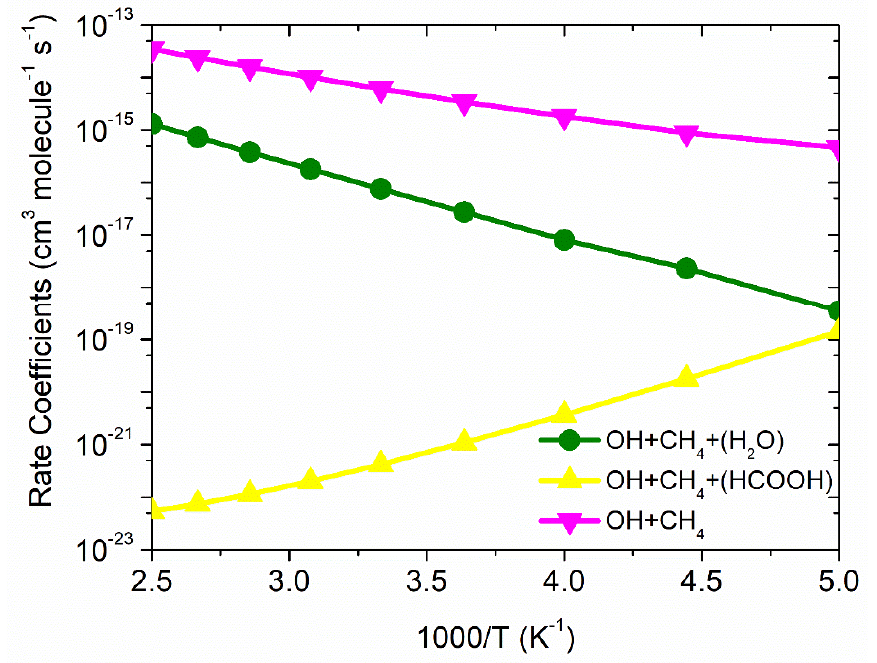
Figure 7. Comparison between rate constants for · OH + CH 4 , · OH + CH 4 + (HCOOH) and · OH + CH 4 + (H 2 O).